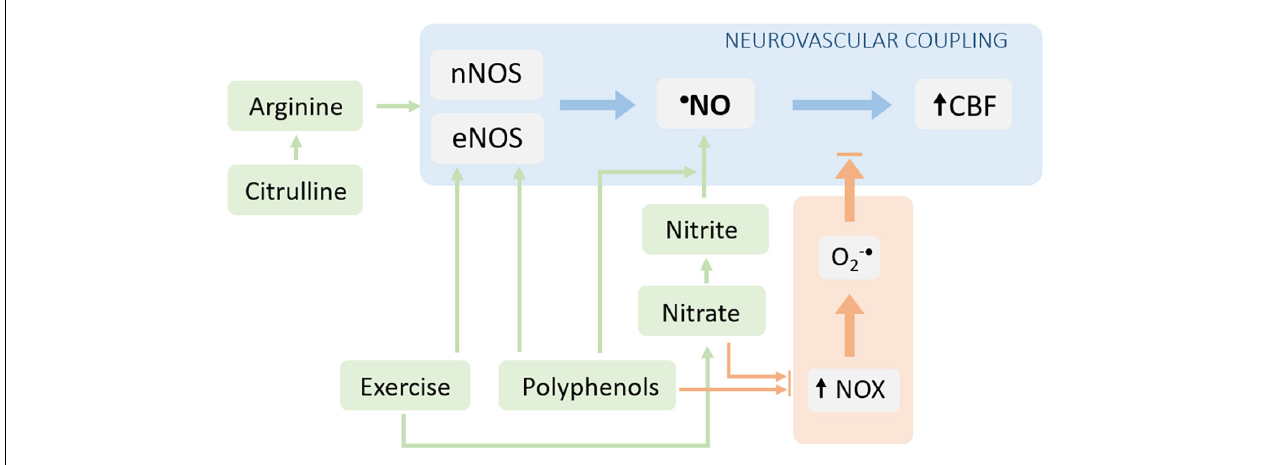
FIGURE 3 | Interventions aiming to target neurovascular coupling dysfunction via reestablishment of • NO bioavailability. The • NO bioavailability can be increased either by stimulating its production (blue arrows) or by decreasing its degradation (orange arrows). The NOS-dependent • NO production can be increased by providing substrates for the enzyme (arginine or its precursor, citrulline) and via the post-translational regulation of the enzyme (e.g., signaling pathways stimulated by polyphenols and/or exercise). Additionally, the • NO synthesis can be enhanced via the alternative nitrate-nitrite- • NO pathway. The limitation of • NO scavenging can be achieved by decreasing the production of superoxide radical (both nitrate/nitrite supplementation and exercise can decrease the activity/expression of NOX